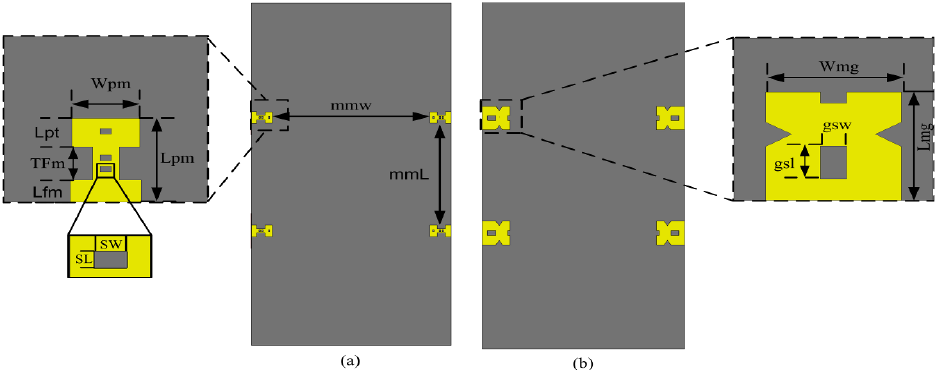
Figure 5. High-band (5G-mmWave) MIMO antenna design: ( a ) front view; ( b ) back view.